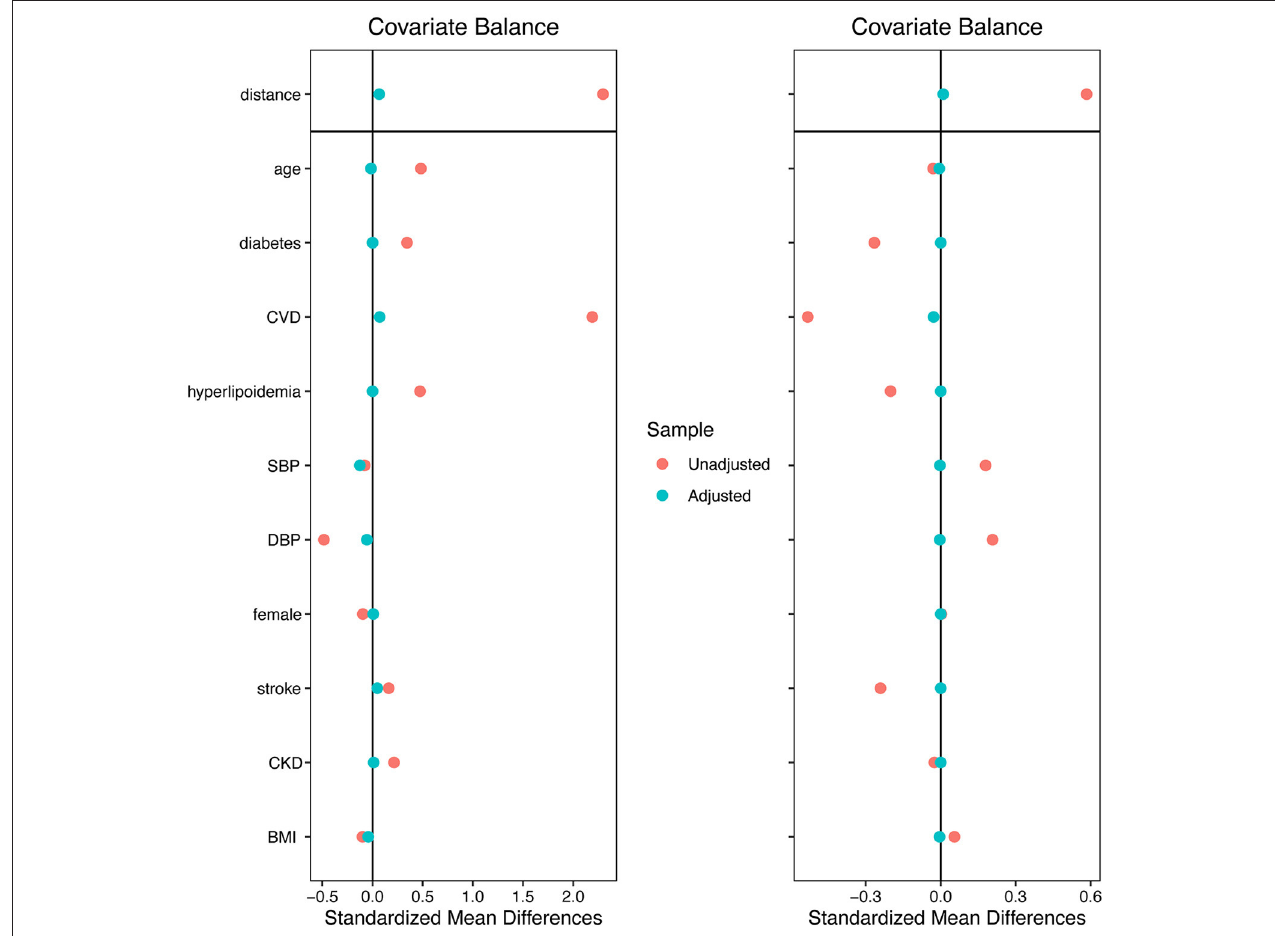
FIGURE 1 | Love-plots with the balance statistic on the X-axis of each matching.